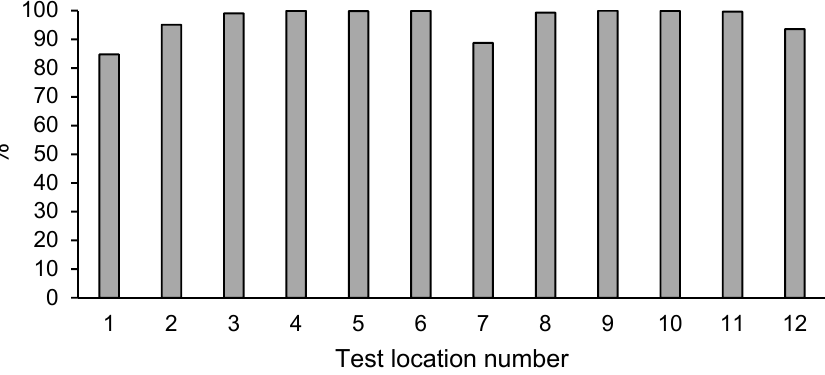
Figure 3. Percentage decrease of naphthalene content in the soil after enhanced natural attenuation.